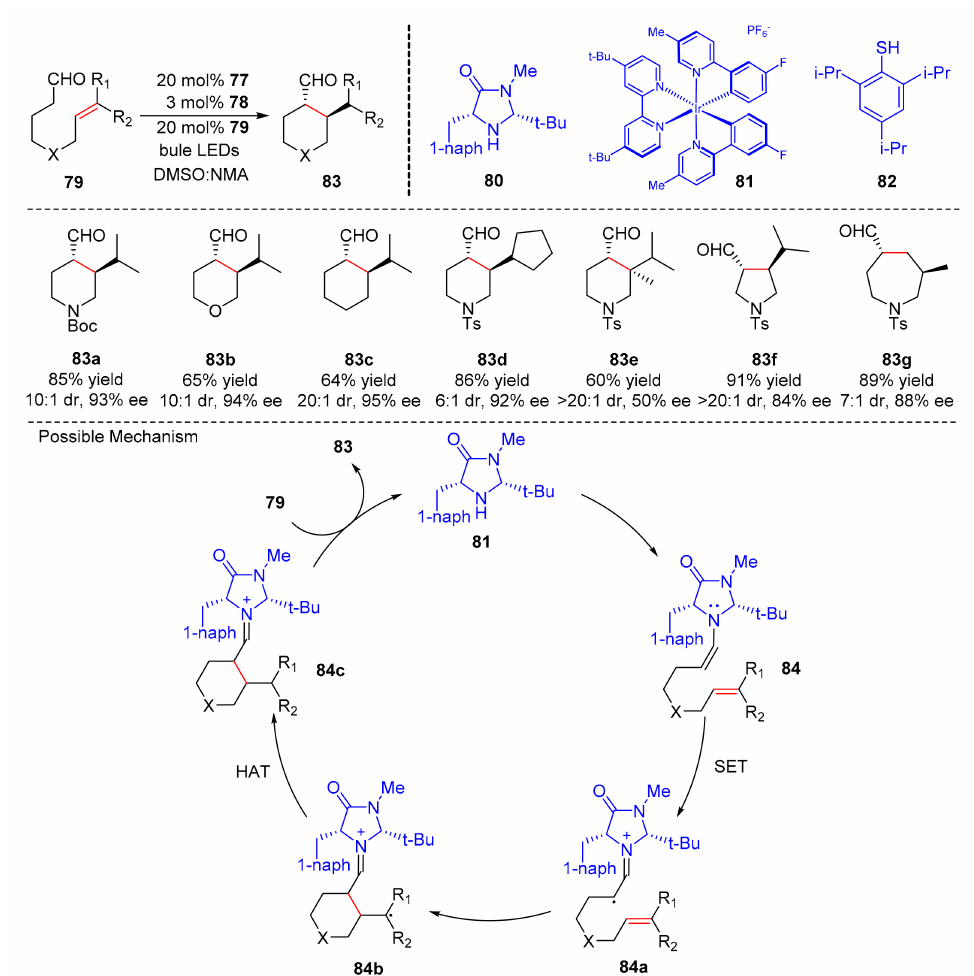
Scheme 19. Intramolecular α -alkylation of aldehydes via a co-catalytic system. In 2017, Luo et al. reported a chiral ion-pair photoredox organocatalyst ( 85 ) which was used for enantioselective anti-Markovnikov hydroetherification of alkenols ( 86 ) to syn- thesize five-membered oxygen-containing heterocyclic adducts ( 87 ) under the irradiation of bule LED light ( λ = 450 nm) in good yields and enantioselectivity (50–90% yield, up to 64% ee). The chiral ion-pair is composed of chiral BINOL-based sodium phosphate and 9-mesityl-10-methylacridinium tetrafluoroborate (Scheme 20) [30]. The aryl substitutions of hydroxyl α -position were well tolerated. Studies have shown that the reaction begins with the chiral ion-pair-catalyzed SET step, which converts the substrates ( 86 ) into radical intermediates ( 88 ), radical intermediates ( 88 ) combine with chiral phosphate anion to form complex ( 89 ), and complex ( 89 ) undergo cyclization to yield cyclic adducts ( 90 ), which through chiral phosphate anion mediated hydrogen transfer to give desired products ( 87